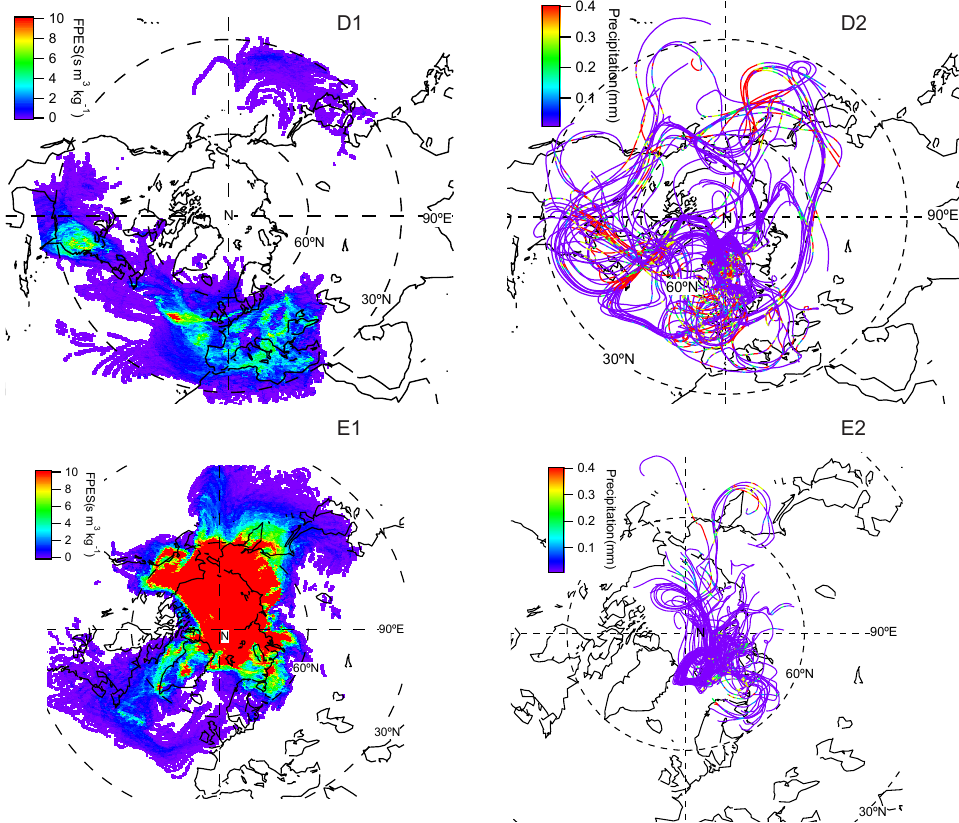
Figure 5. The FLEXPART FPES (left panels from a1–e1 ) and the corresponding HYSPLIT backward trajectories (right panels from a2–e2 ) for each classified air mass origin, representing flight B759 10:50–11:15, B760 08:45–09:45, B761 12:10–12:25, B761 15:06–15:15 and B759 15:15–15:45 respectively. Each backward trajectory is coloured by precipitation along the pathway and the open circles with numbers in panels (a2) , (b2) and (c2) mark the time backwards along the trajectory in 1-day intervals.